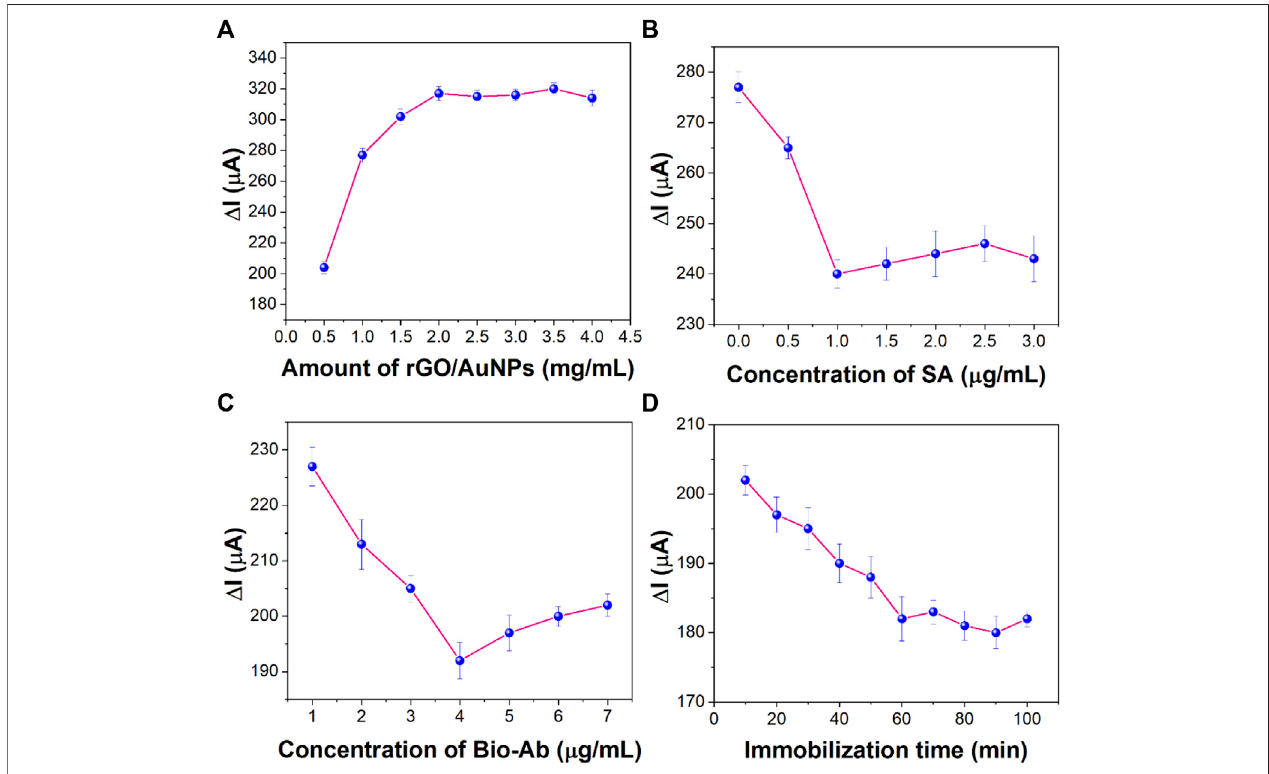
FIGURE7| Effectof (A) concentrationofrGO/AuNPnanocomposites, (B) concentrationofSA, (C) concentrationofBio-Ab,and (D) immobilizationtimeofCEAon the sensing performance ( n =